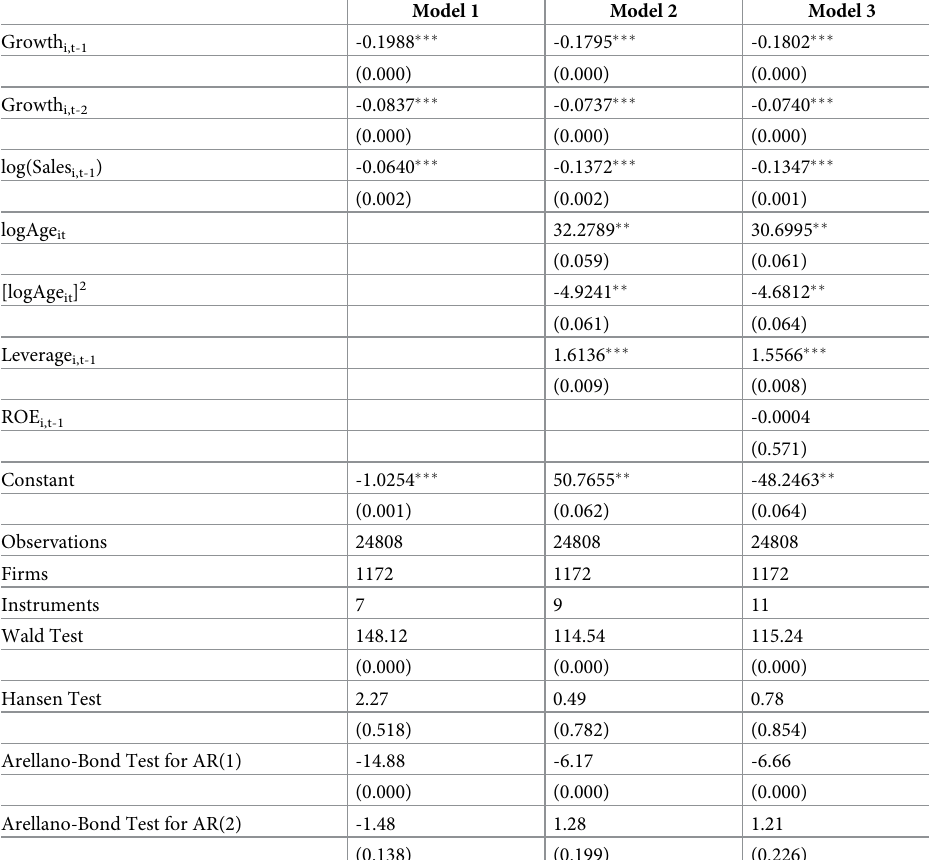
Table 4. Determinants of business